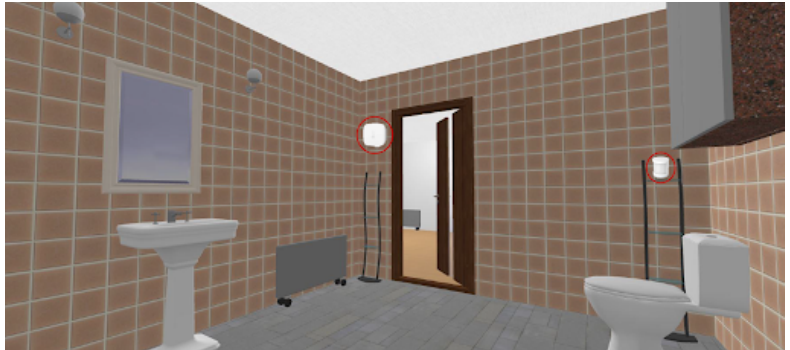
Figure 24. Sensors deployed in the living room.